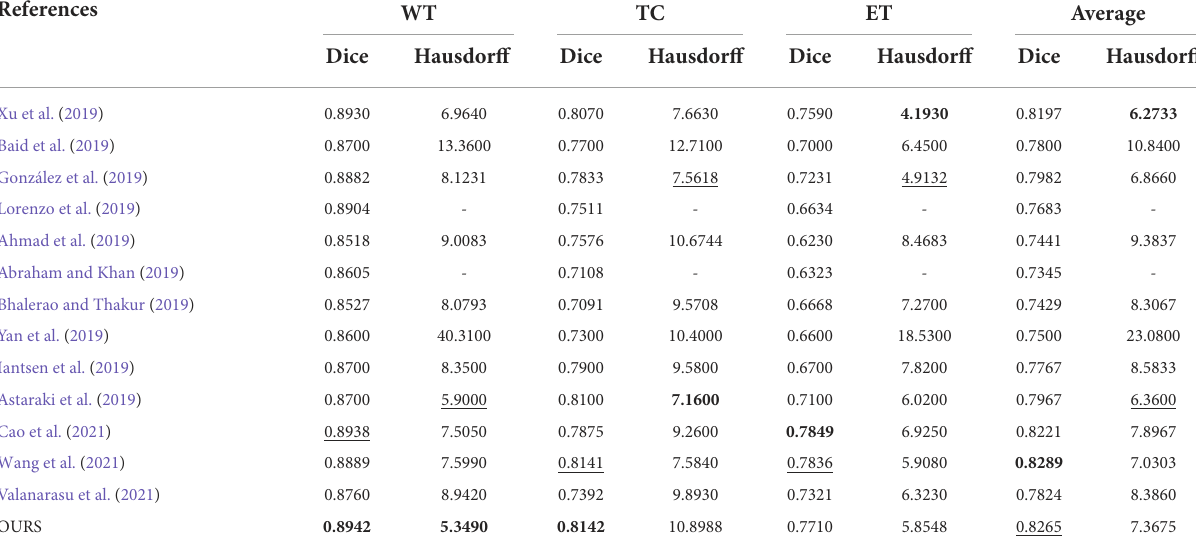
TABLE 4 Objective evaluation results of different brain tumor segmentation methods on the BraTS 2019 validation sets.